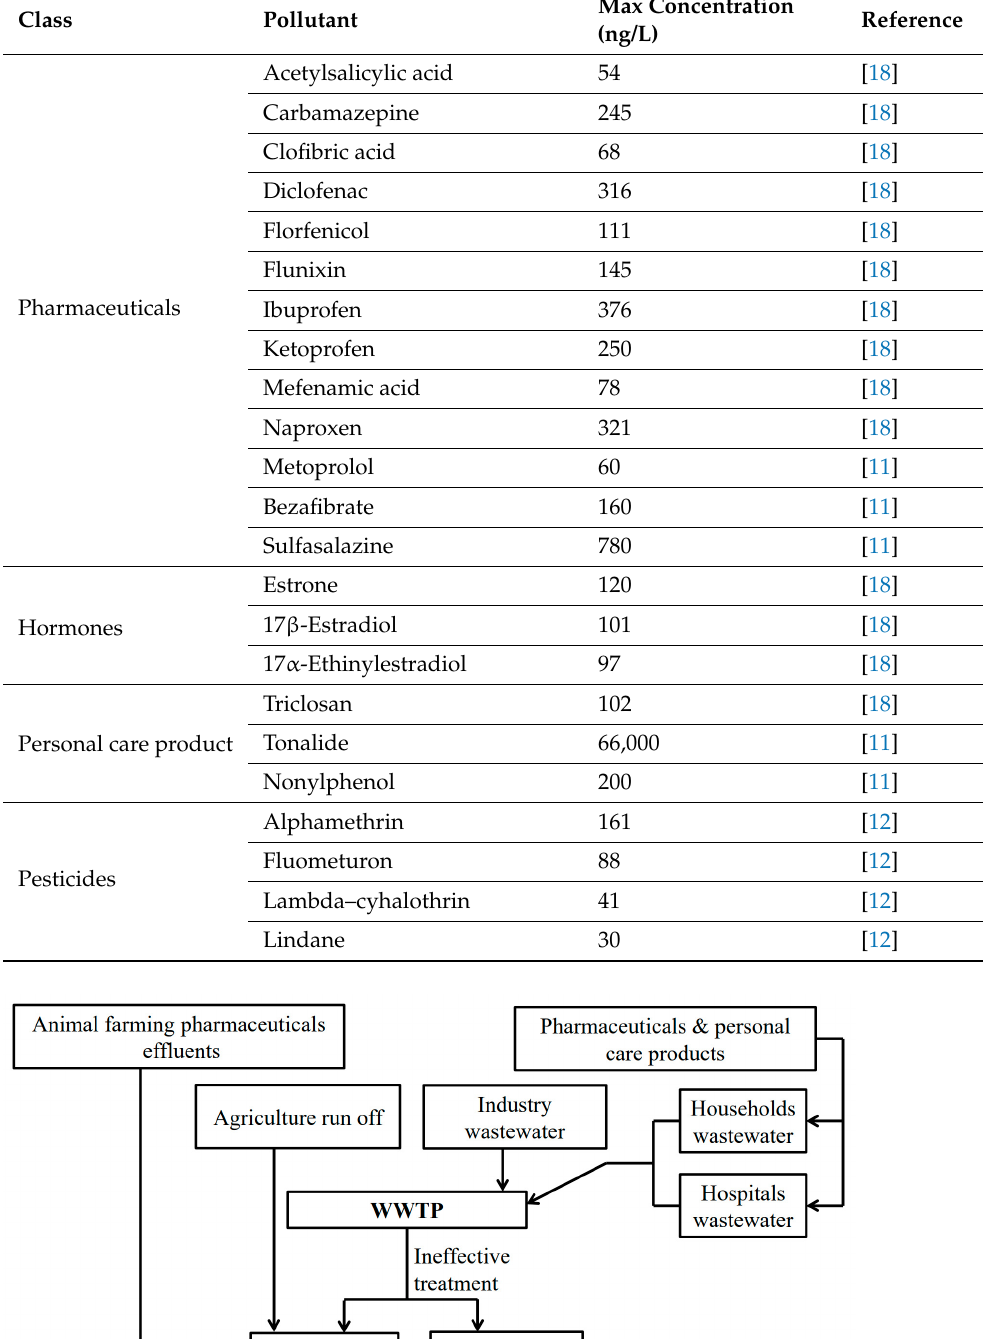
Table 2. Different classes and concentrations of EPs detected in different water bodies.